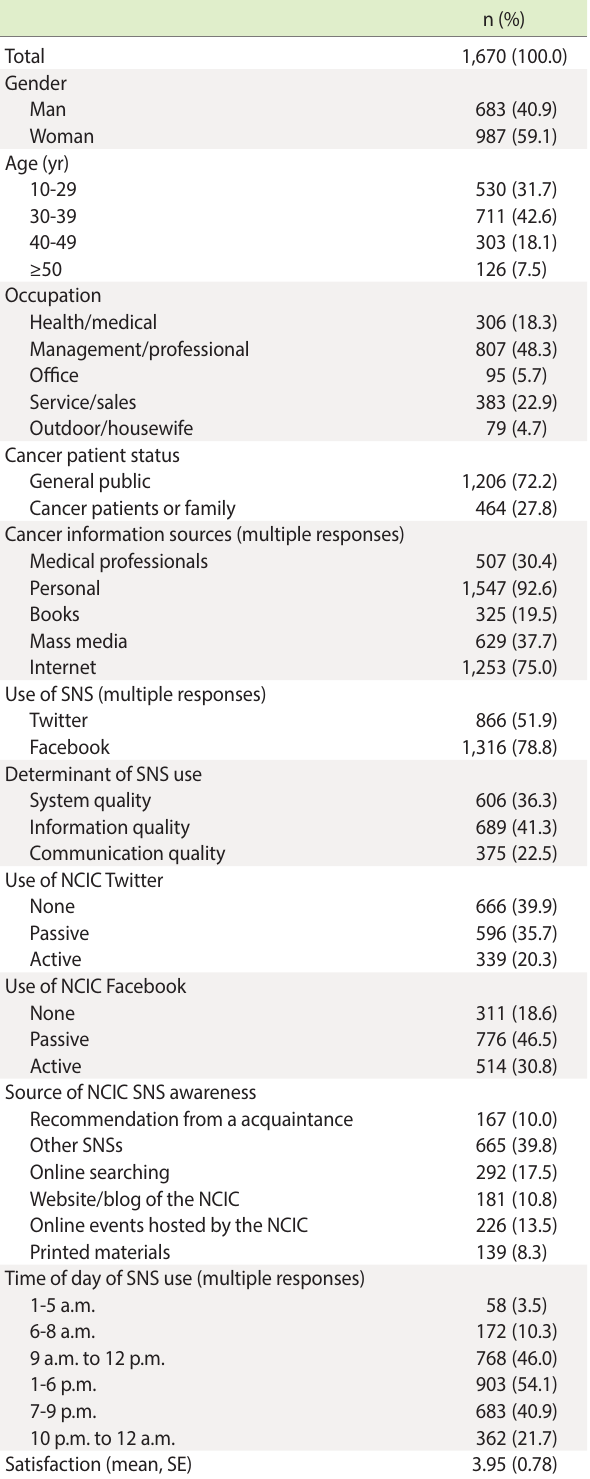
Table 1. Characteristics of participants and SNS usage